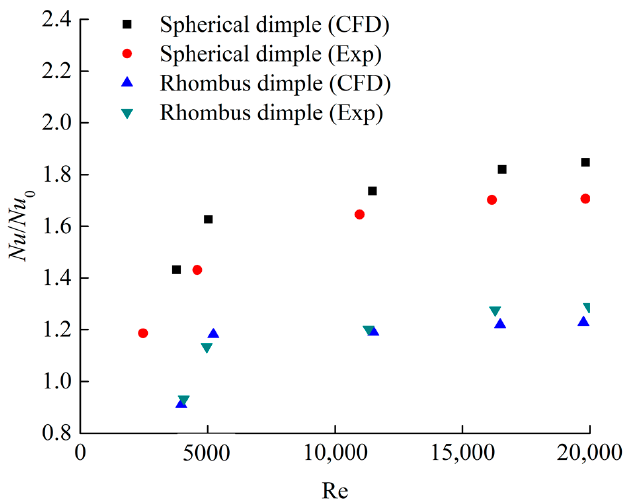
Figure 11. Heat transfer enhancement of the dimpled channels.